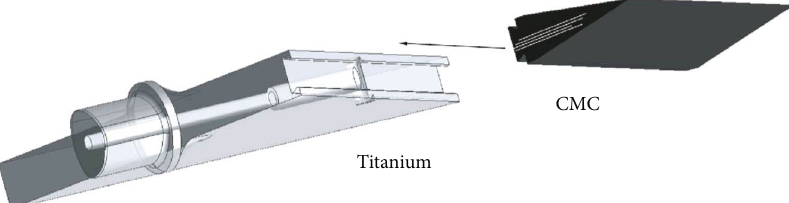
Figure 16: Dovetail